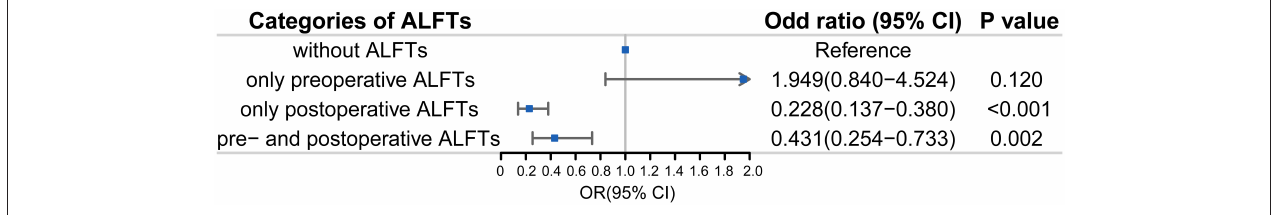
hospitalization are conjectured to be major mechanisms of post-procedural